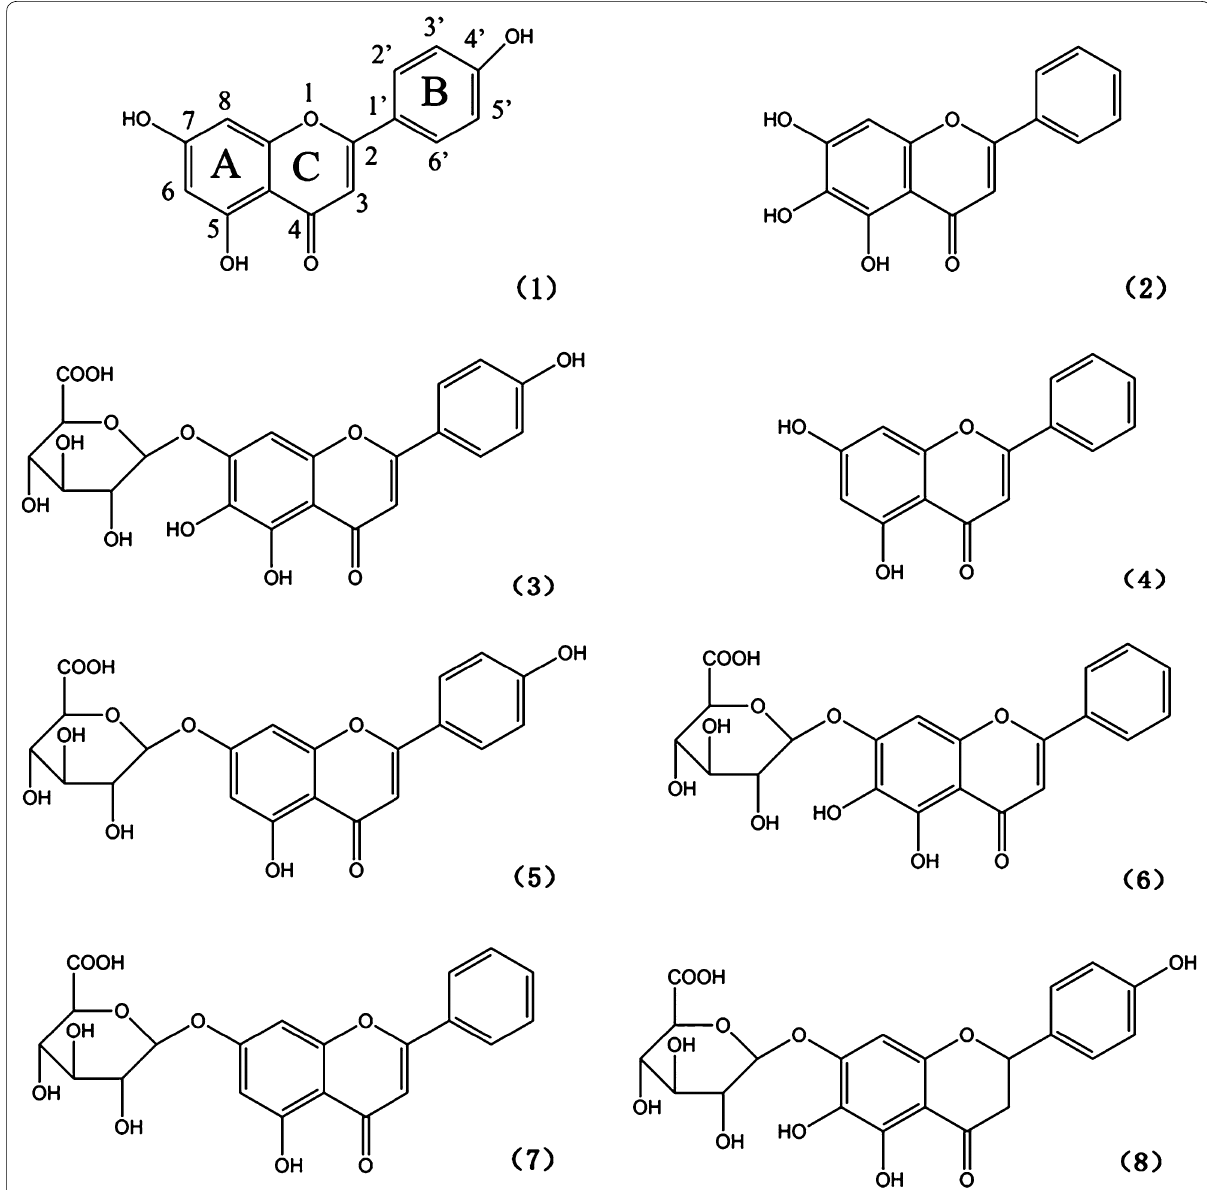
Fig. 3 Chemical structures of the eight high content flavonoids arranged in a decreasing order of inhibitory effects against both α-glucosidase and α-amylase. (1) Apigenin; (2) baicalein; (3) scutellarin; (4) chrysin; (5) apigenin-7- O -glucuronide; (6) baicalin; (7) chrysin-7- O -glucuronide; (8) isocarthamidin-7- O